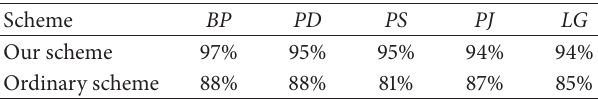
Table 4: Pattern recognition accuracy comparisons for our scheme and ordinary color moment-based scheme